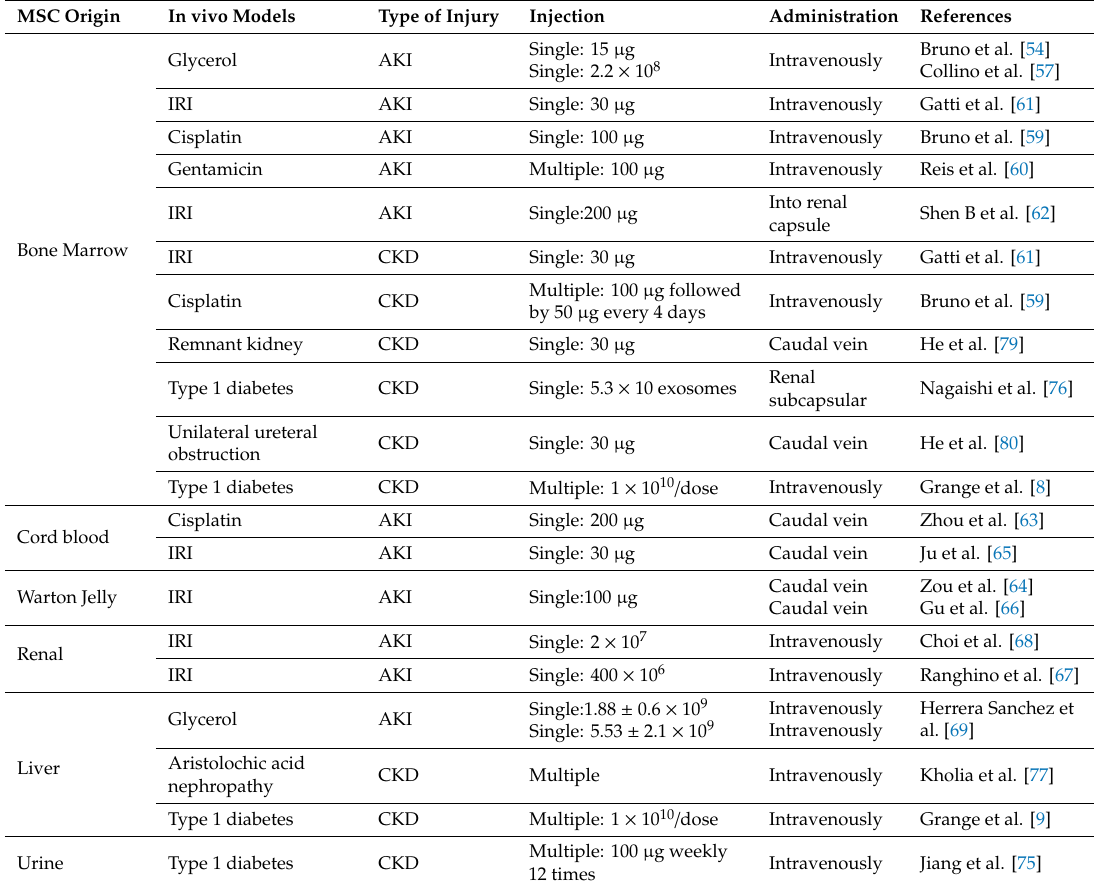
Table 1. Mesenchymal stromal cell-extracellular vesicle (MSC-EV) administration in animal models of renal damage. EVs released by MSCs derived from di ff erent tissues are e ff ective in models of acute kidney injury (AKI) and chronic kidney disease (CKD). EV sources, animal models, doses, and route of administration are listed. Abbreviation: IRI Ischemia Reperfusion